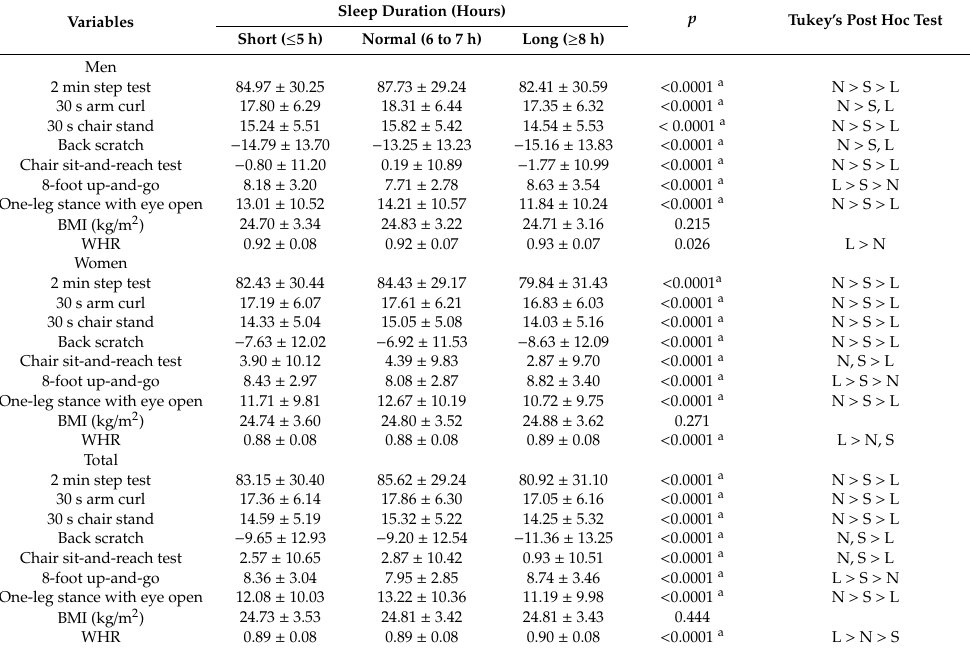
Table 2. The comparison of physical fitness measurements according to sleep-duration levels.